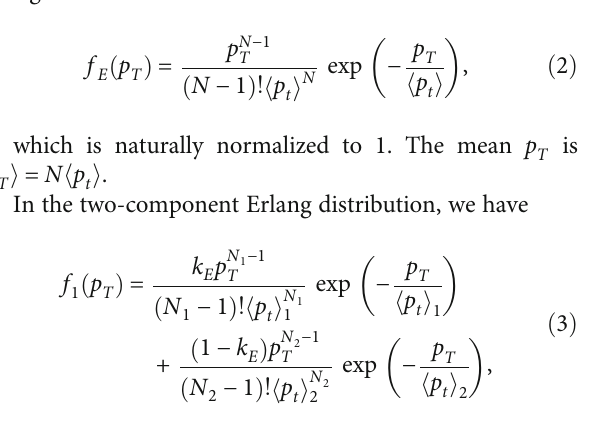
Figure 1: Transverse momentum spectra, (a – c) ð 1/2 π p di ff erent decay or production modes in (a – c) Au + Au , (d, e) p + p , (f) p + (cid:1) p , and (g) Pb + Pb collisions at energies (a) 39, (b) 62.4, (c) 200, (d) 500, and (e) 510GeV, as well as (f) 1.8 and 1.96, and (g) 2.76TeV. The experimental data represented by the symbols are measured by the (a – e) STAR [13, 14], (f) CDF [15, 16], and (g) ALICE Collaborations [18] with di ff erent centrality classes such as (a – c) 0-20%, 20-40%, 40-60%, and 0-60%, and (g) 0-20%, 20-40%, and 40-90%, as well as with di ff erent cross sections, e.g., (d, e) full and fi ducial cross sections. Some data points are scaled by di ff erent amounts marked in the panels. The data points are fi tted by the (two-component) Erlang distribution (Eq. (3), the solid curve), the Hagedorn function (Eq. (4), the dashed curve), and the Tsallis-Levy function (Eq. (6), the dotted curve),